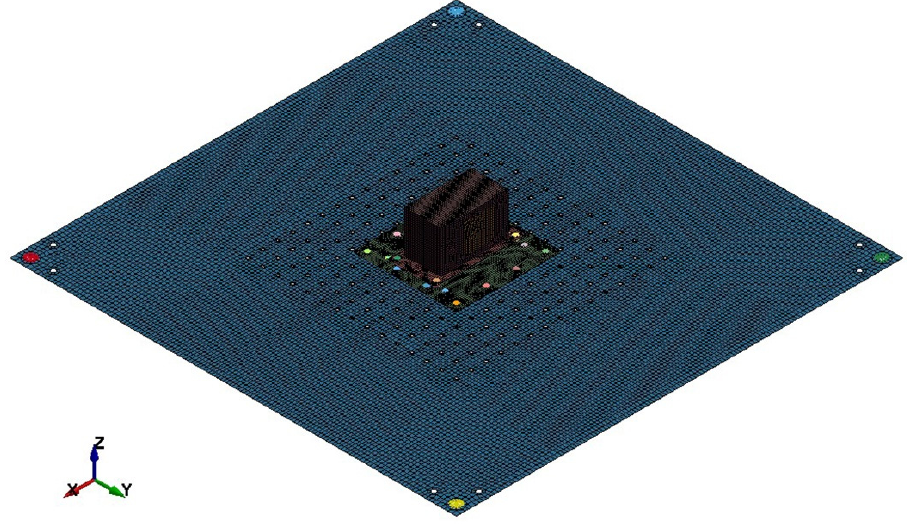
Figure 13. Finite element model with the dummy instrument.